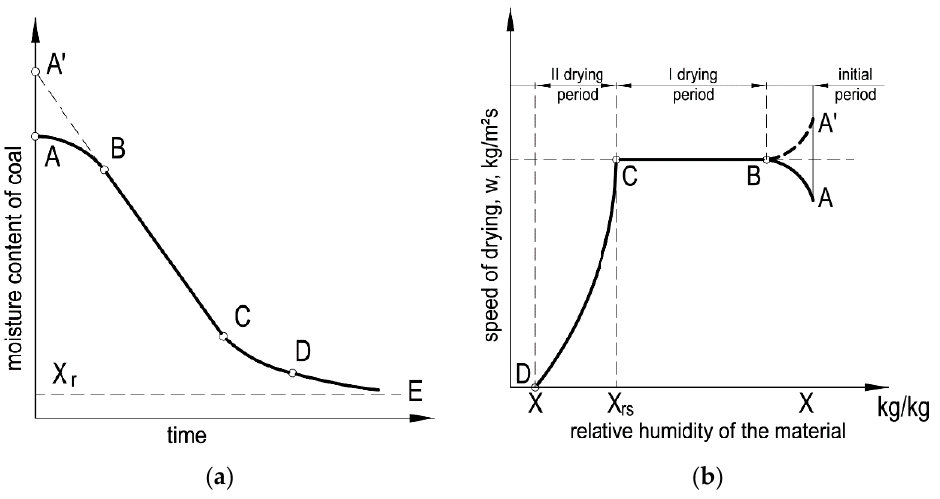
Figure 8. Curves characterizing the drying process: ( a ) drying curve; ( b ) drying speed curve [45].